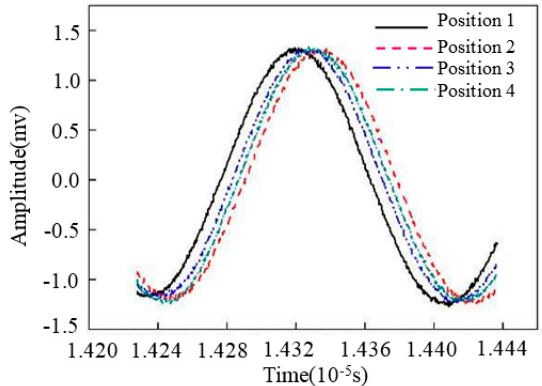
Figure 4. Rayleigh wave signals of laser cladding Fe314 alloy coating responding to the zero stress [51]. “Reproduced with permission from published by © Springer.” (2015).